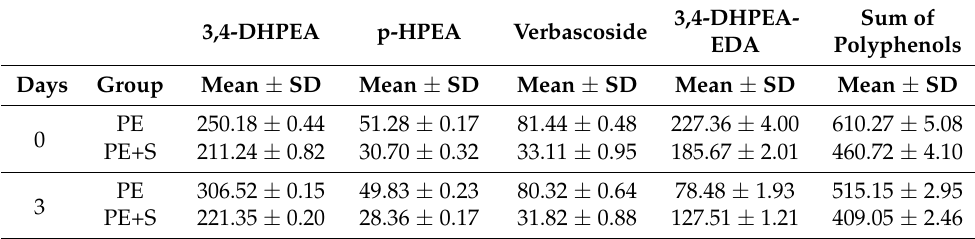
Table 1. Phenolic compounds (mg/kg) evolution during storage in raw shrimps (before boiling) treated with tap water solution containing 2 g/L of phenols (PE) and 0.25% sodium metabisulfite tap water solution containing 1 g/L of phenols